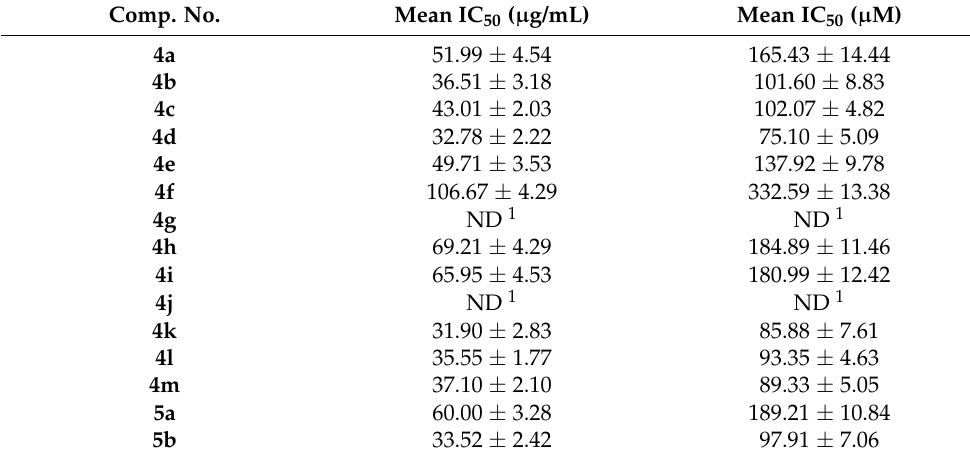
Figure 3. Cytotoxic potency of the studied compounds on HCT-116 cells expressed as percentages of viable cells at 10, 25, 50 and 100 µg/mL concentrations. Results were obtained from three independent experiments. Table 4. IC 50 values of cytotoxicity for the studied 4 H -pyran and pyrano[2,3- c ]pyrazole derivatives on HCT-116 cells expressed in µ g/mL and µ M. Experiments were performed in triplicate and are reported as the means ± standard